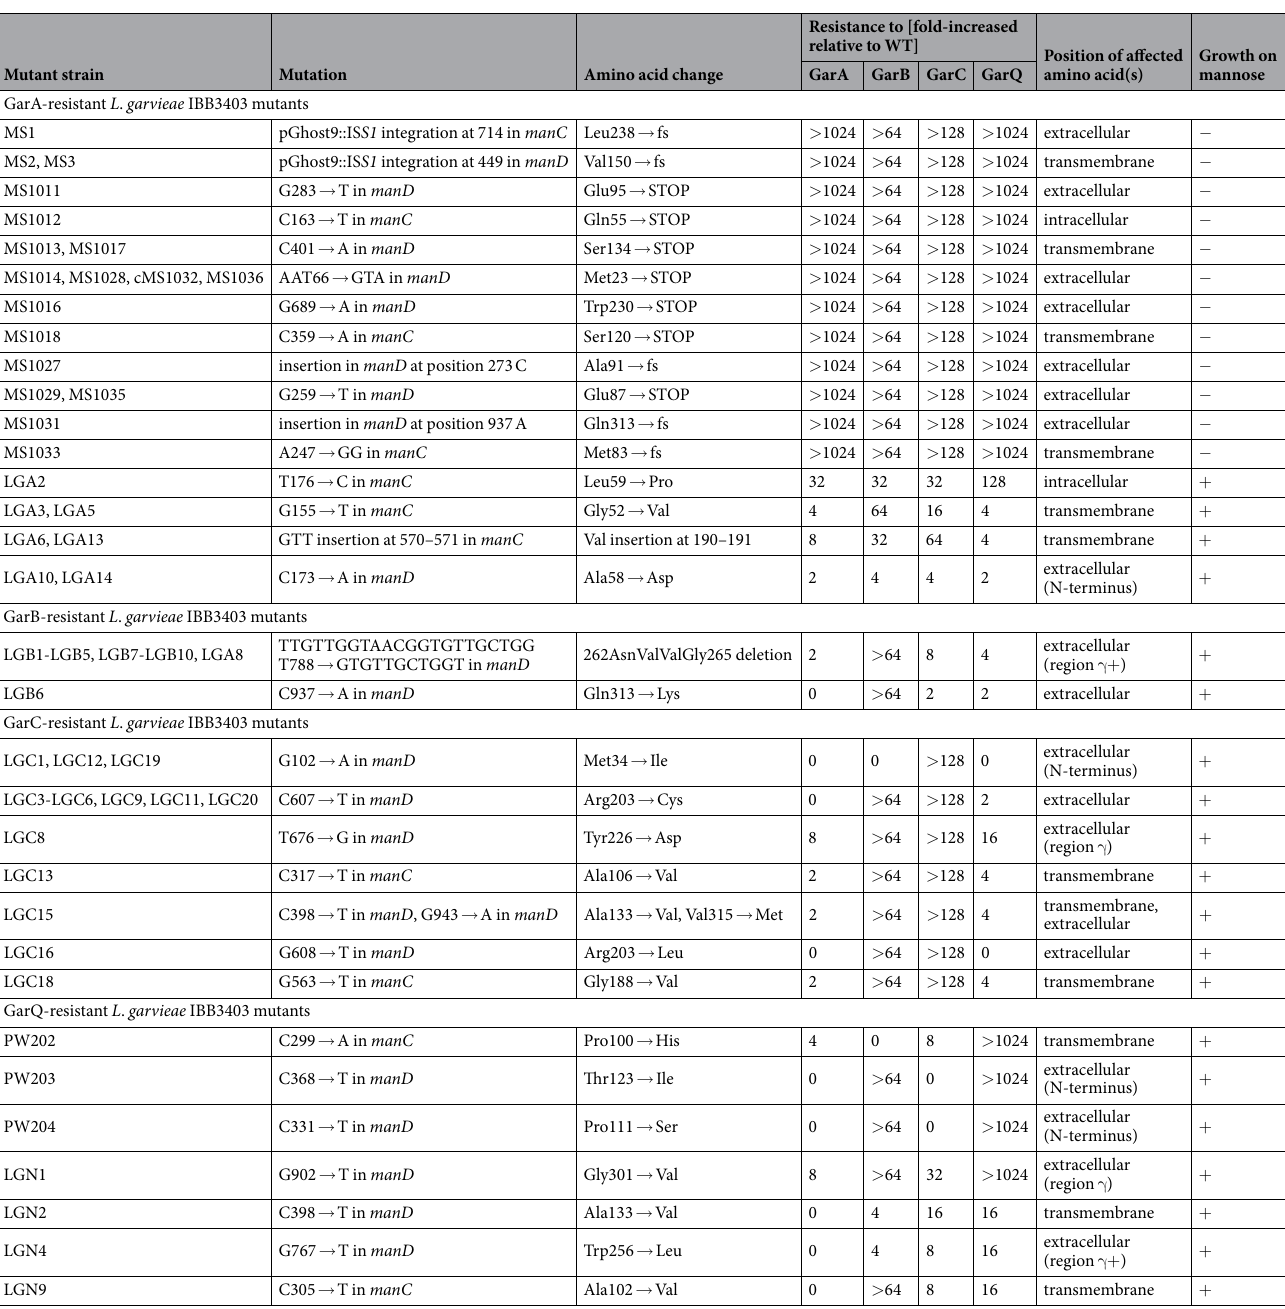
Table 1. L . garvieae IBB3403 mutants resistant to GarA, GarB, GarC and